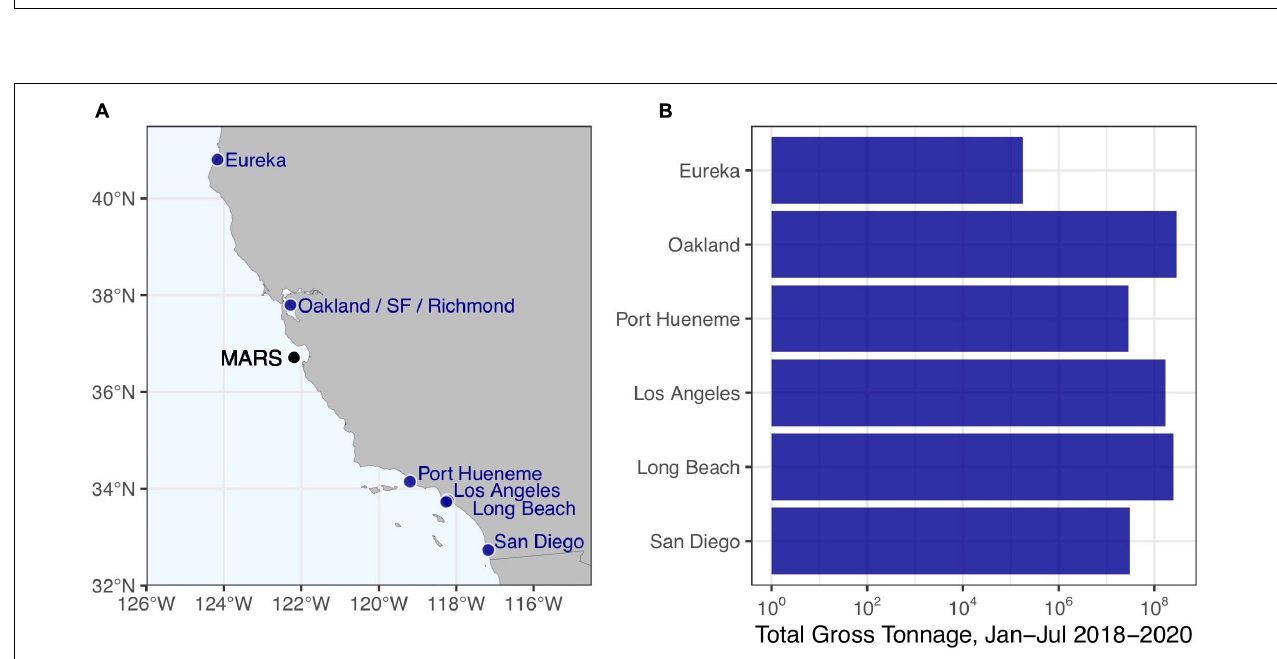
FIGURE 6 | Reduction of low-frequency noise during 2020. (A) Monthly statistics for spectrum levels computed from MARS recordings (location in Figure 1 ) for a frequency band that is representative of low-frequency vessel noise (one-third octave band centered at 63 Hz, Figure 4 ). Shown are the range of the 10th–90th exceedance levels (light gray bars), the median and interquartile range (colored boxes), and the geometric mean (white circles). Asterisks indicate months during which spectrum levels were lower during 2020 by at least 1 dB re 1 µ Pa 2 Hz − 1 relative to at least one of the two preceding years. (B) Percentile-dependent differences between 2020 and the prior 2 years. (C) Monthly percent of time during which 1-min L50 values were more than 3 dB re 1 µ Pa 2 Hz − 1 above the overall time-series mean.